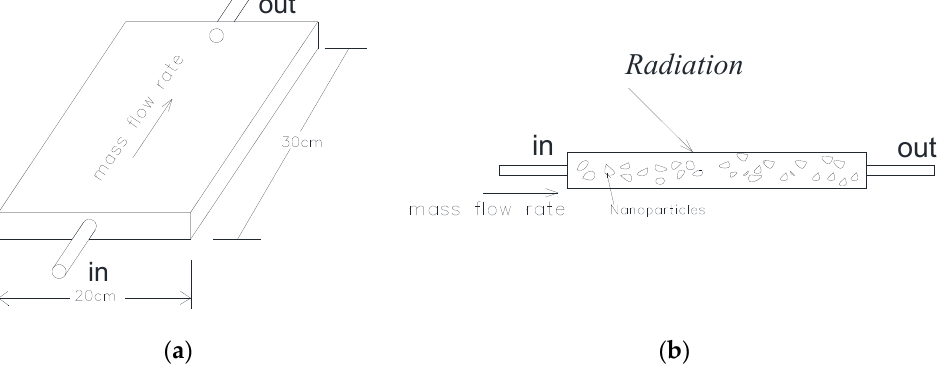
Figure 1. Diagram of the direct absorption solar collector. ( a ) Isometric, ( b ) side view.